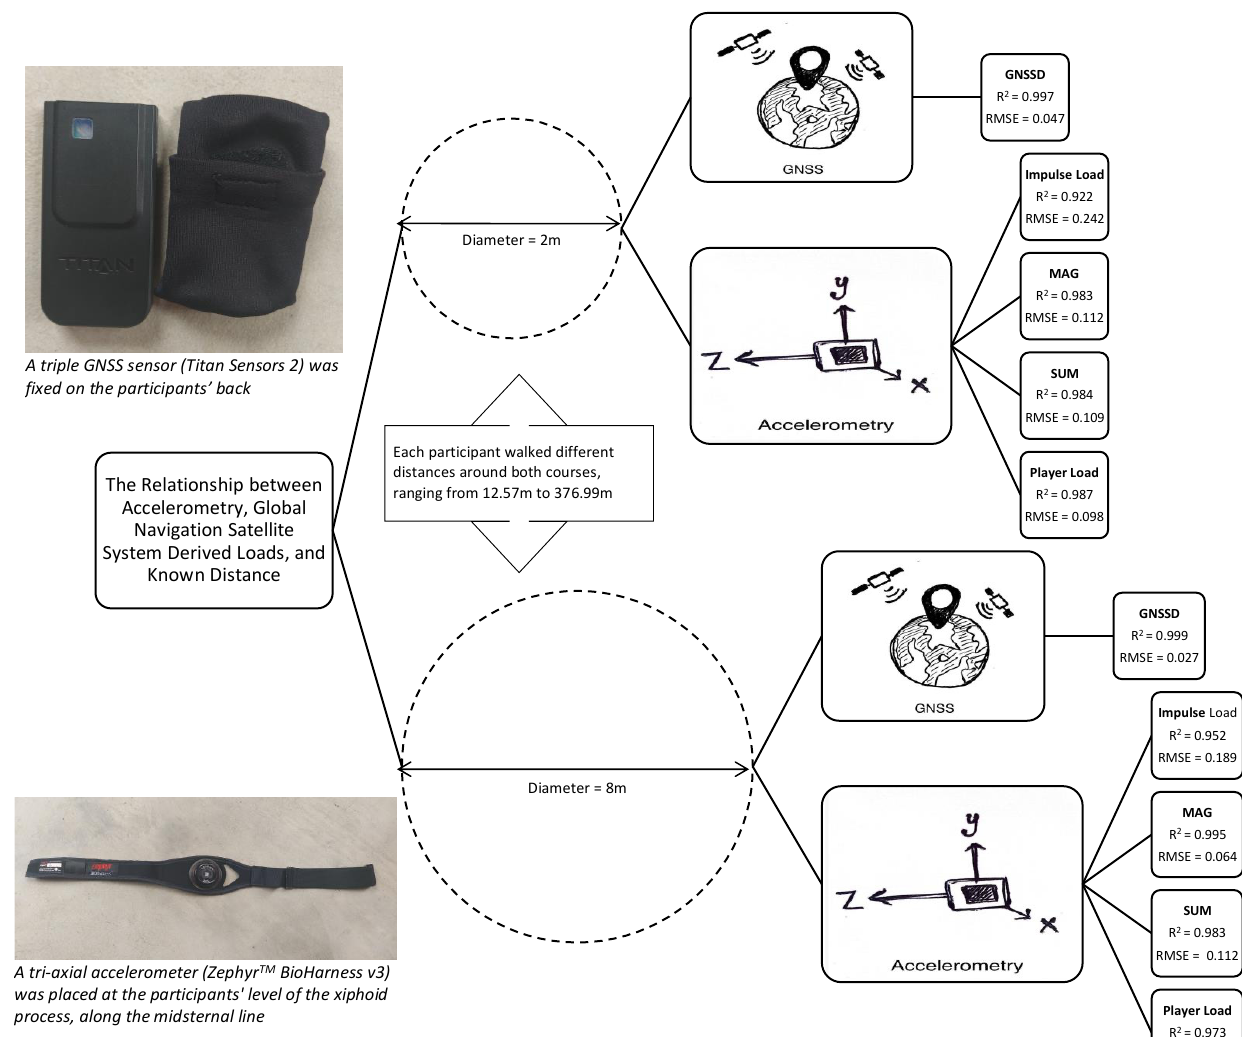
Figure 7. Demonstration and summary of the study results. Previous research has indicated that, independent of movement velocity (i.e., walk, jog, run, sprint), rapid directional change degrades GNSS accuracy. For instance, GNSS may underestimate distance during shuttle trials (−2.16 ± 3.84%) and overestimate distance during exercise completed on curvilinear tracks (2.99 ± 2.96%) [31]. However, the